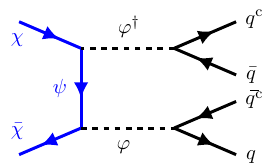
Figure 12 . Tree-level diagram for dark matter annihilation. Z 2 -odd fields are indicated by blue lines and